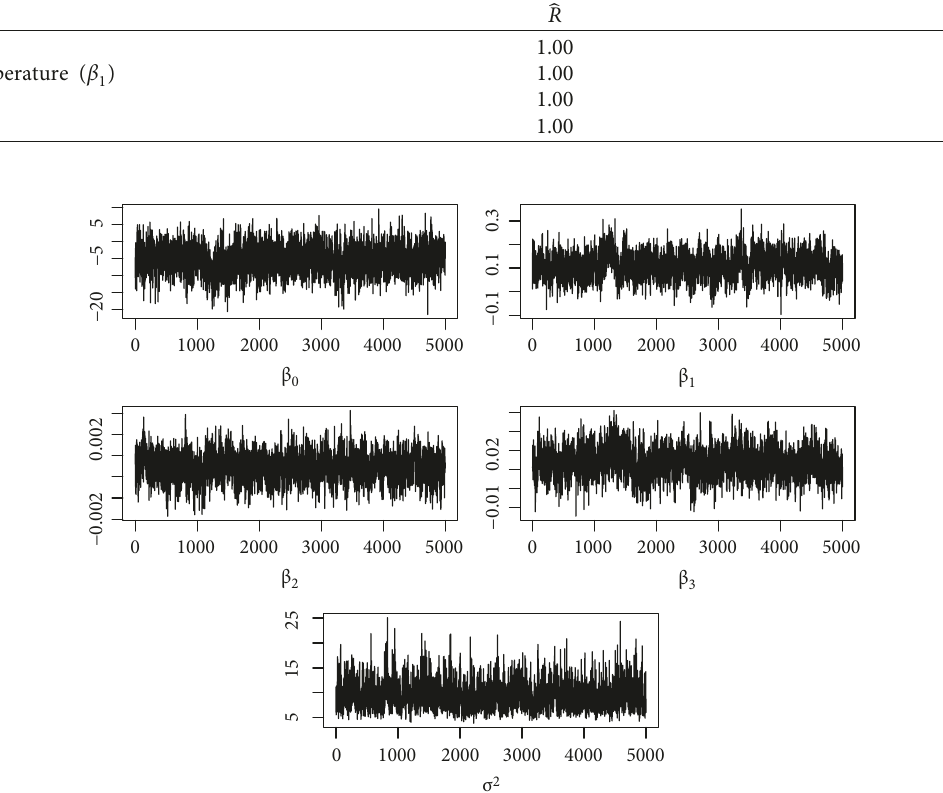
Figure 6: Time series plots showing the MCMC output every 10-th